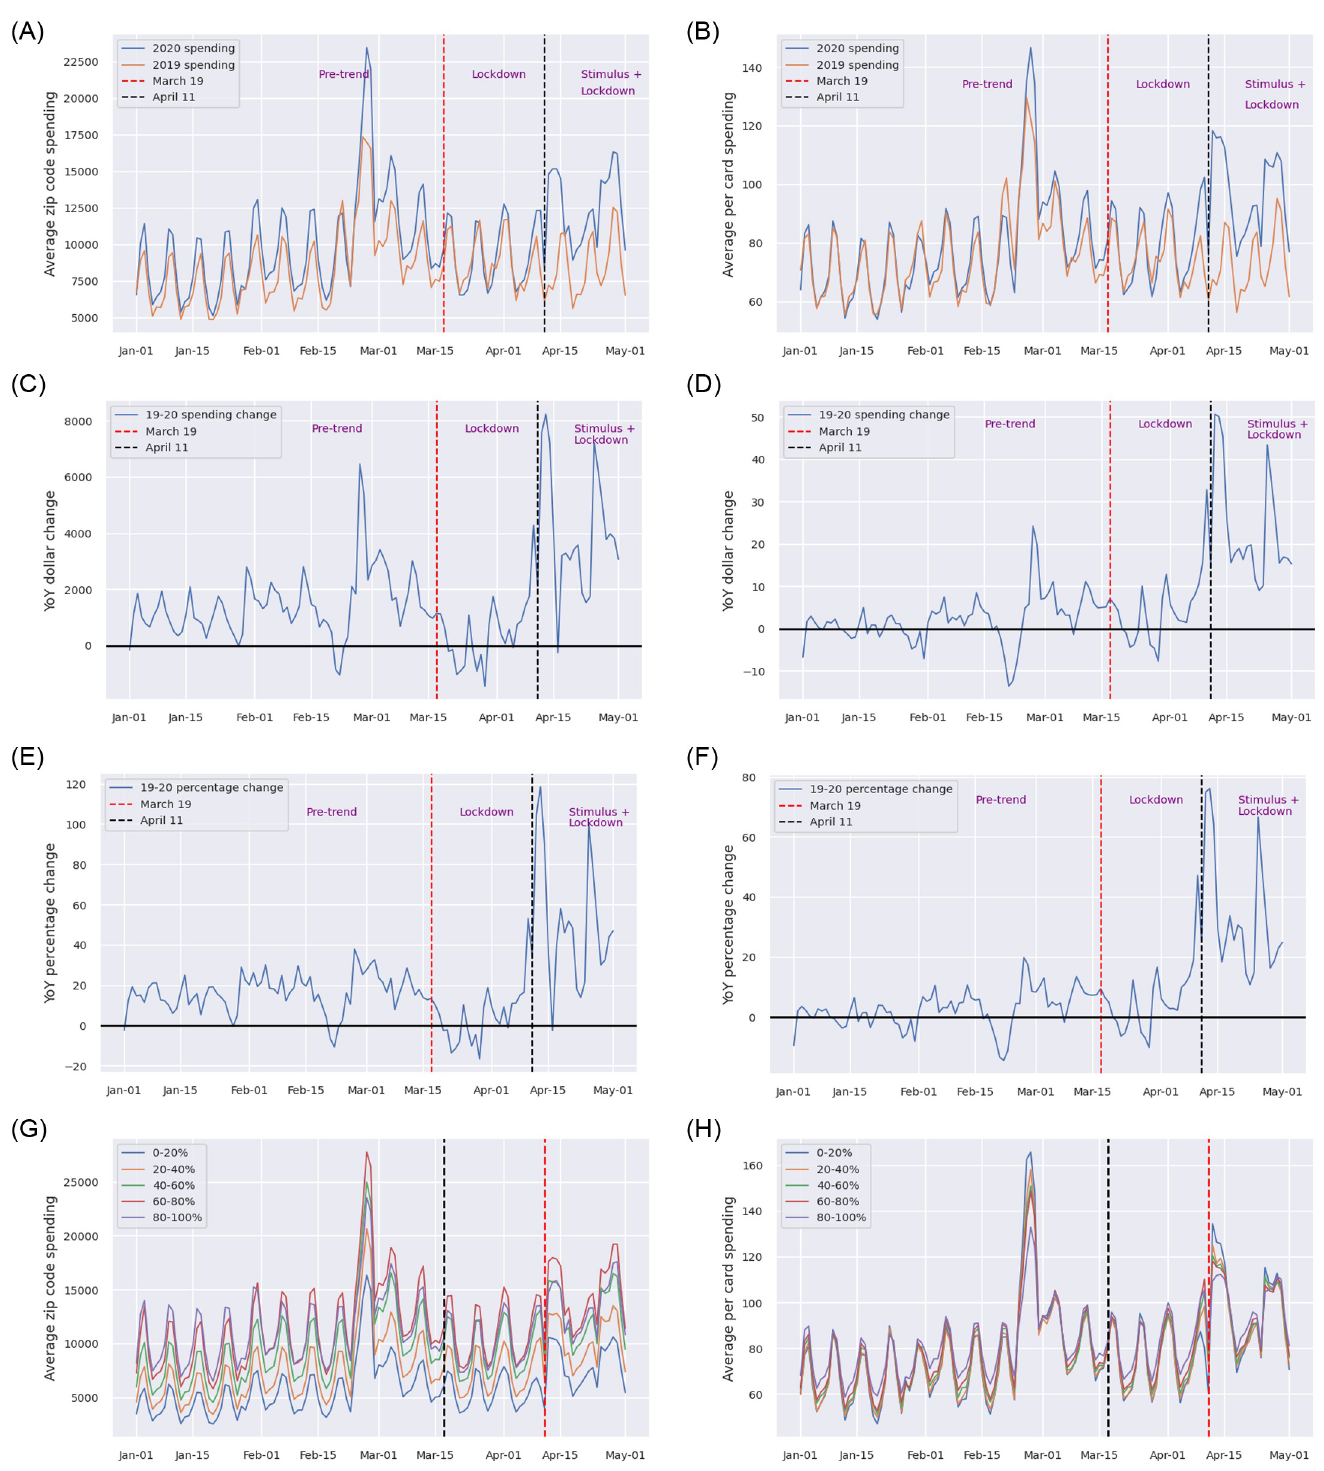
Fig 2. Trends of daily average zip code spending and daily average per card spending from Jan 1 to May 3 of 2019 and 2020. The dates are adjusted to match the day of the same week across 2019 and 2020. (a) Trend of daily average zip code spending. (b) Trend of daily average per card spending. (c) Trend of YoY dollar change in daily average zip code spending. (d) Trend of YoY dollar change in daily average per card spending. (e) Trend of YoY percentage change in daily average zip code spending. (f) Trend of YoY percentage change in daily average per card spending. (g) Trend of daily average zip code spending by income quintile. (h) Trend of daily average per card spending by income